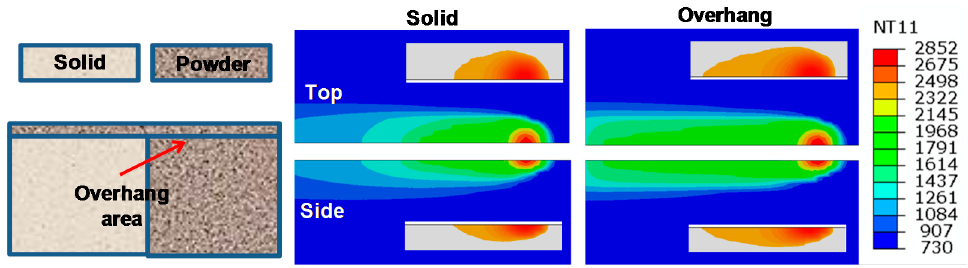
Figure 2. Thermal response from simulations of electron beam additive manufacturing (EBAM)-fabricating an overhang part.